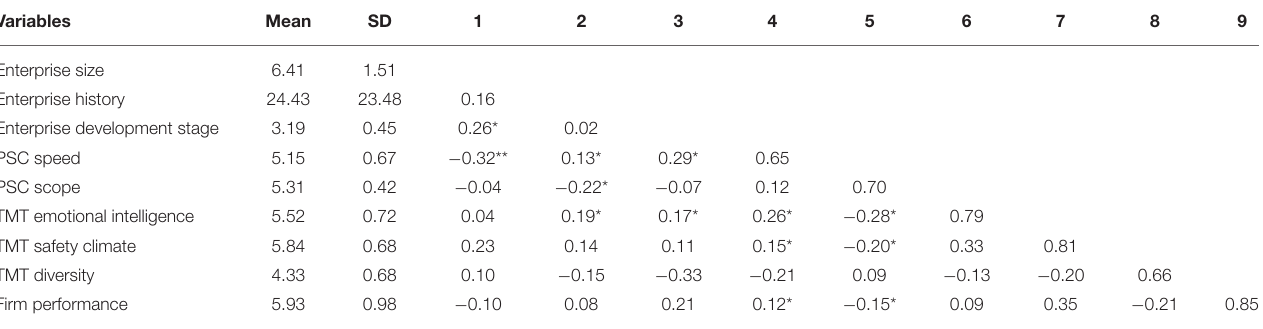
TABLE 2 | Construct correlations.